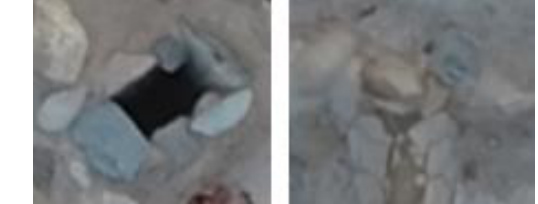
Figure 5. An excerpt of the 7mm resolution orthophoto of the Phrygian village. Each stone is clearly readable.